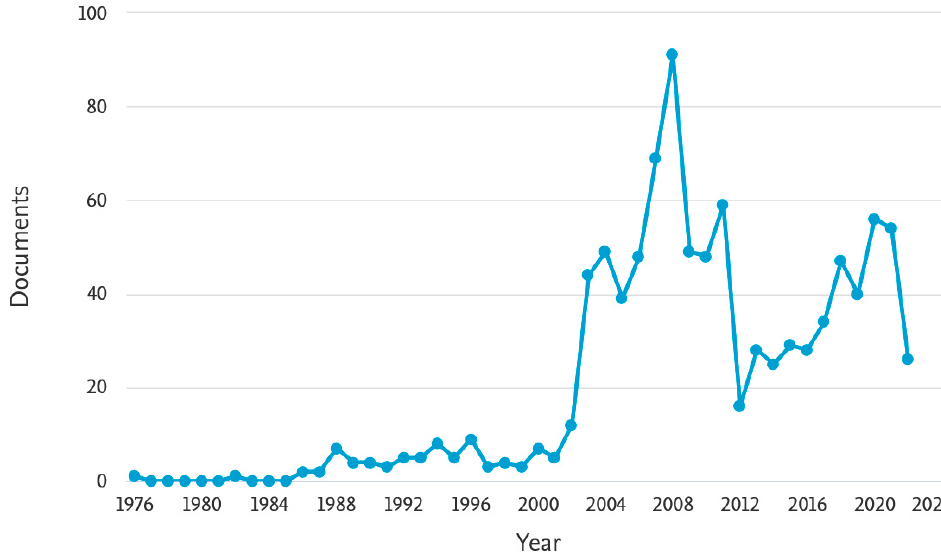
Figure 1. Documents published per year (Scopus). Table 2. Main sources of published documents.